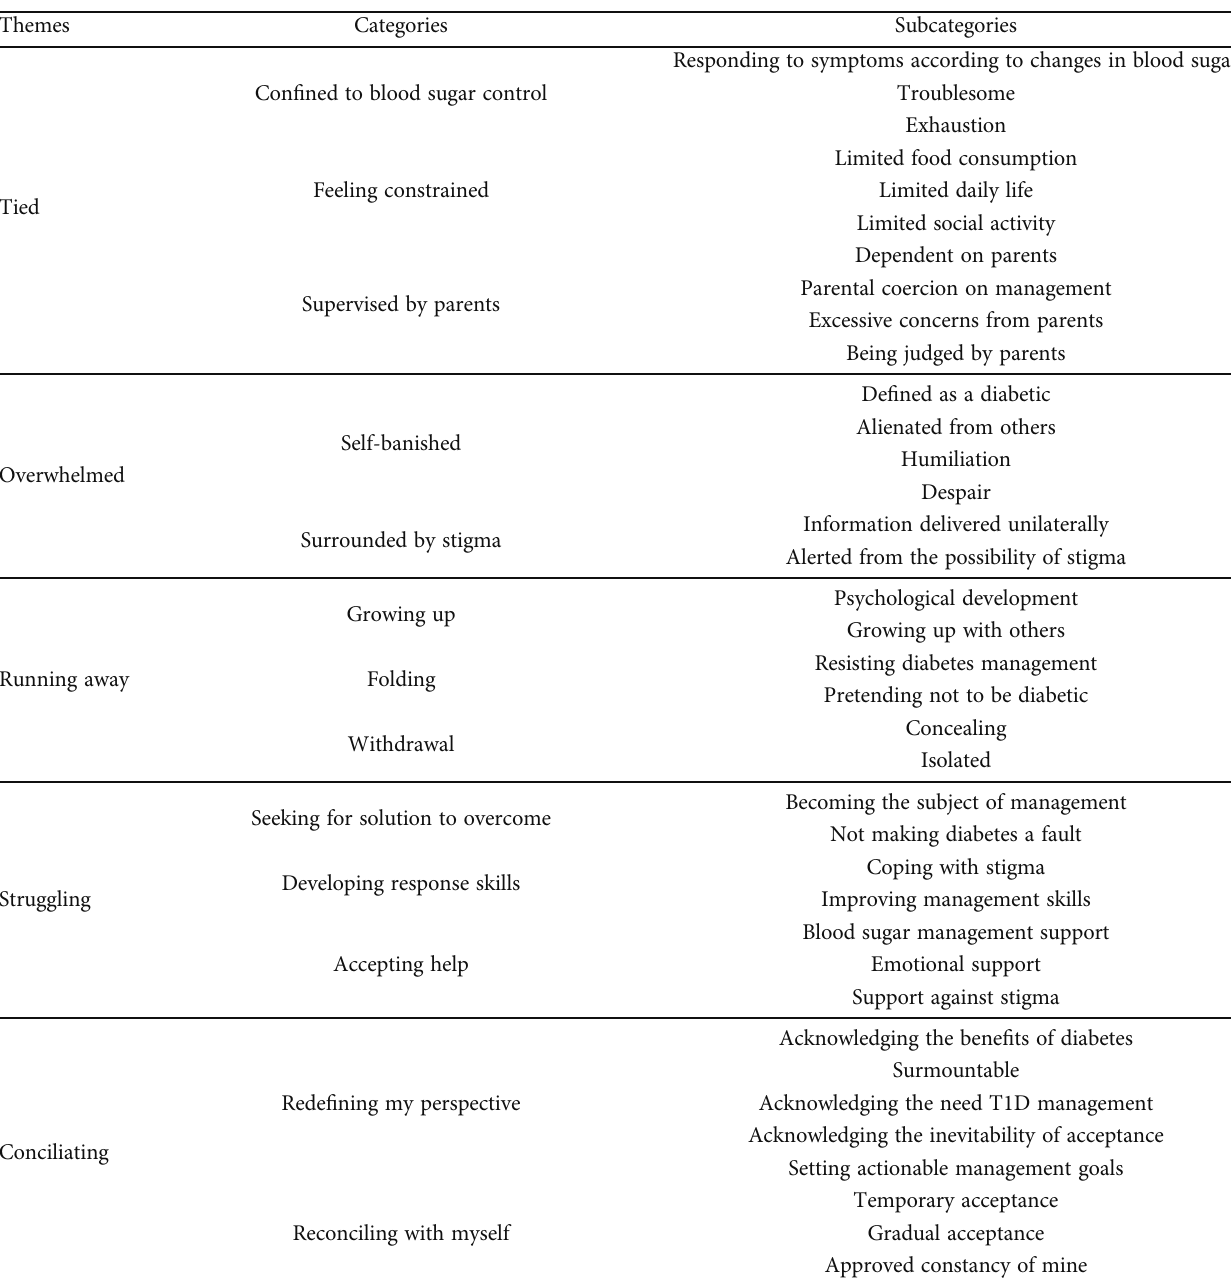
Table 2: Themes, categories, and